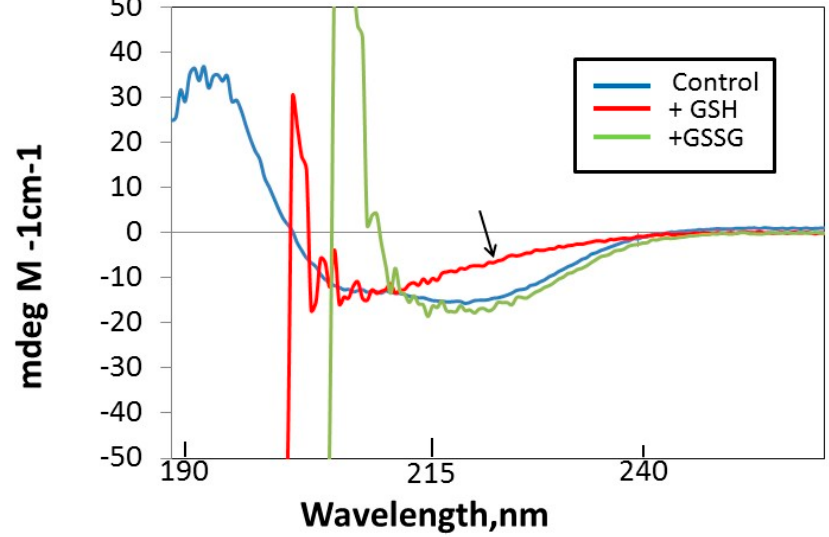
Figure 4. GSH-induced change in the secondary structure of Prdx6 as evaluated by far UV circular dichroism (CD). There is decreased (negative) molar ellipticity at 210–240 nm in the presence of GSH (arrow); there was no effect of GSSG at this wavelength.